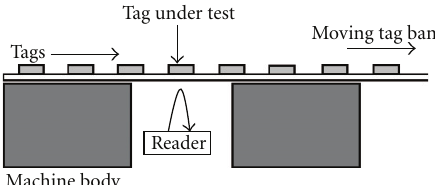
Figure 1: Setup for exclusively reading one single tag on a production machine.